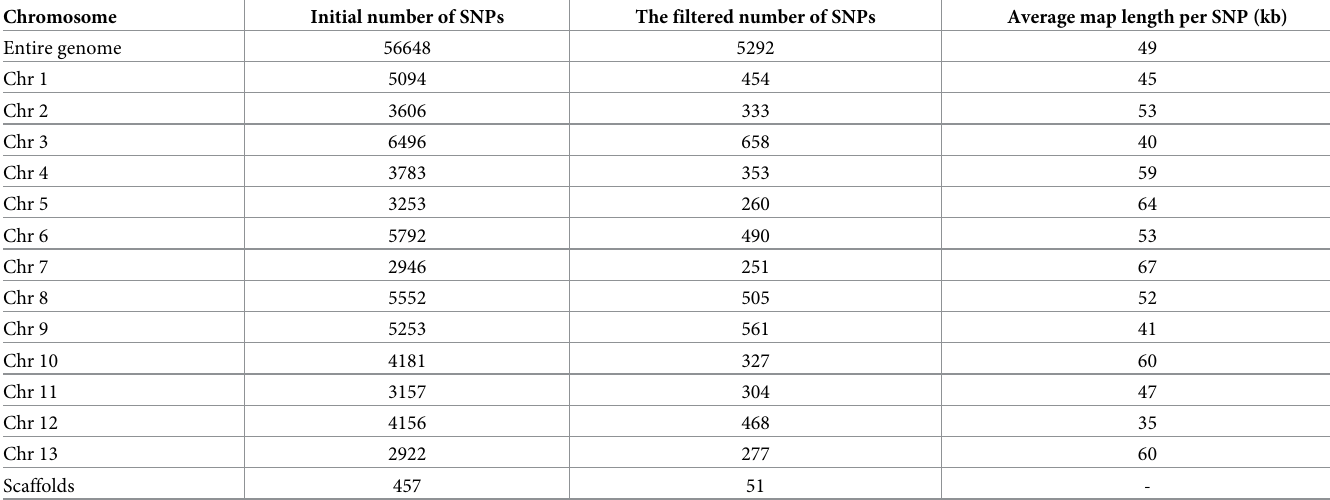
Table 1. Distribution SNPs in of each chromosome.